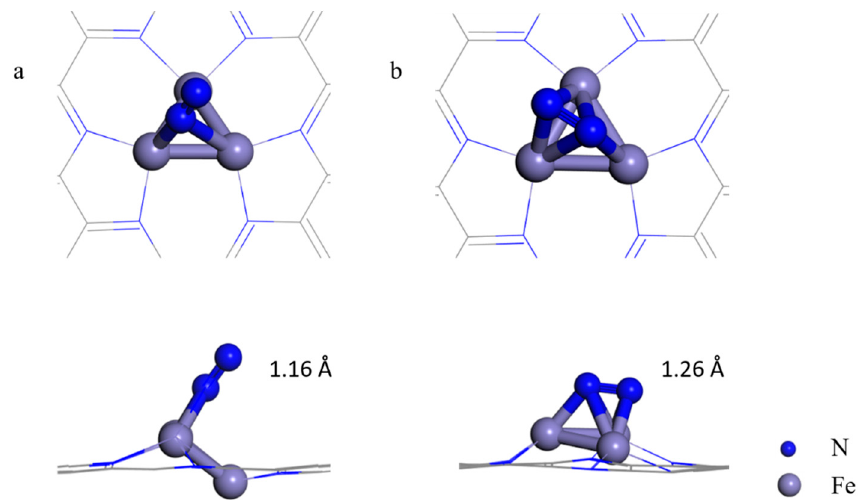
Figure 2. Top and side views of N 2 adsorbed on the Fe 3 @C 2 N with the end-on ( a ) and side-on configuration ( b ).